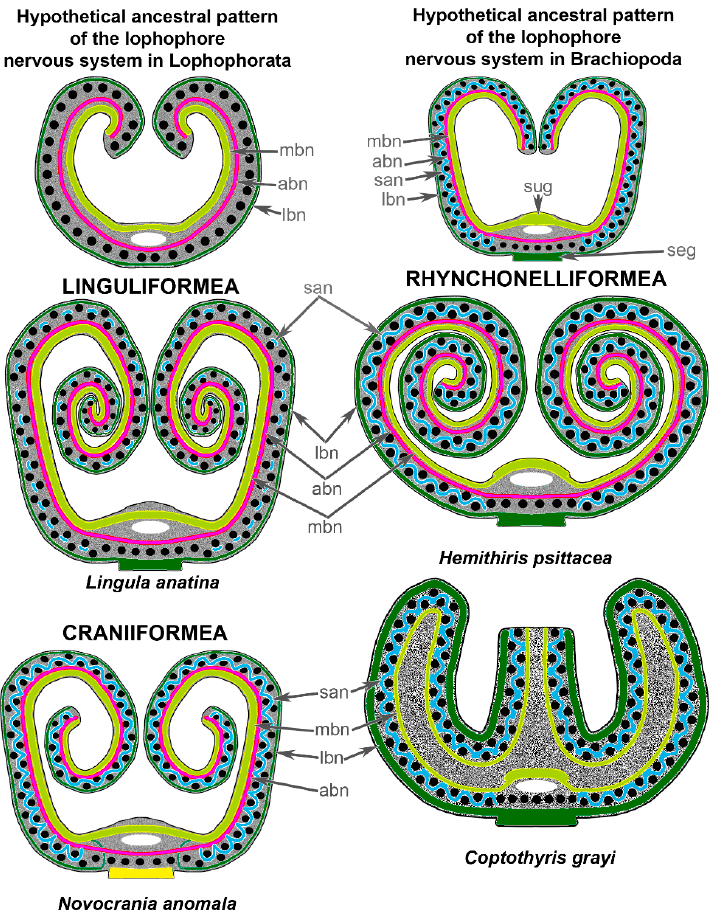
Figure 9. Scheme of the lophophore nervous system in brachiopods from all three subphyla. The reconstruction is based on previous [15,27,28] and recent studies. The black circles indicate tenta- cles. Colors indicate different nerve elements of the lophophore: yellow–green—main brachial nerve and the supraenteric ganglion; pink—accessory brachial nerve; blue—second accessory brachial nerve; dark green—lower brachial nerve and the subenteric ganglion. Abbreviations: